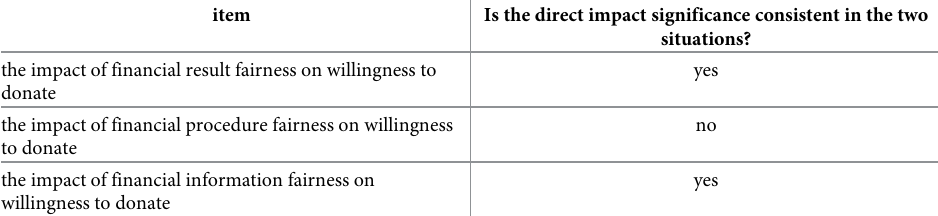
Table 12. Consistency comparison of the direct influence path. item Is the affect path consistent in the two situations? the impact of financial result fairness on willingness to donate yes the impact of financial procedure fairness on willingness to no donate the impact of financial information fairness on willingness to donate